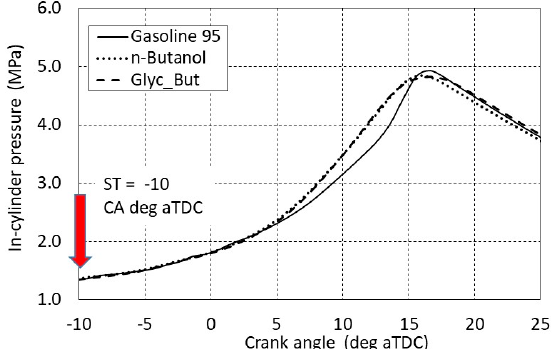
Figure 2. In-cylinder pressure traces vs. crank angle for the tested fuels at fixed spark timing of − 10 CA deg aTDC.